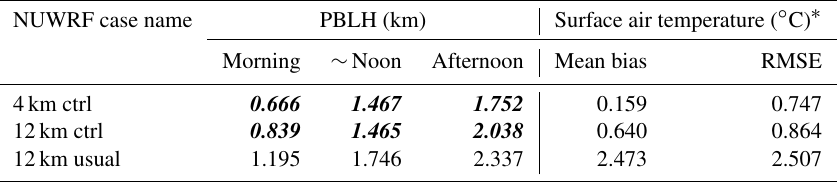
Figure 3. Evaluation of NUWRF (a) surface air temperature ( ◦ C) at ∼ 13:00 local standard time, (b) surface soil moisture (m 3 m − 3 ), and (c) normalized surface soil moisture at ∼ 00:00 local standard time (NUWRF initial time) over the central–southeastern US on 11 Septem- ber 2013. NUWRF simulations are shown in the first three columns; NCEP surface in situ temperature observations and the ESA CCI combined daily soil moisture product (0.25 ◦ × 0.25 ◦ , only showing data with quality flag = 0) are shown in the right column. The uncer- tainty of the CCI product on 11 September 2013 is shown in Fig. S2 (left). The normalized anomaly is defined in Eq. (3) in the text, and Fig. S2 (right) shows the size of usable CCI data in September 2013. Note that for (b, c) , warm (cool) colors indicate high (low) soil moisture values, opposite to the commonly used color scheme in hydrological studies. Control is denoted by ctrl. Table 3. NUWRF-simulated median PBLH (km) and daytime (06:00–17:00 local standard time) surface air temperature performance at different times of 11 September 2013, around Conroe, TX. The bold italic numbers were used to derive emissions. Control is denoted by